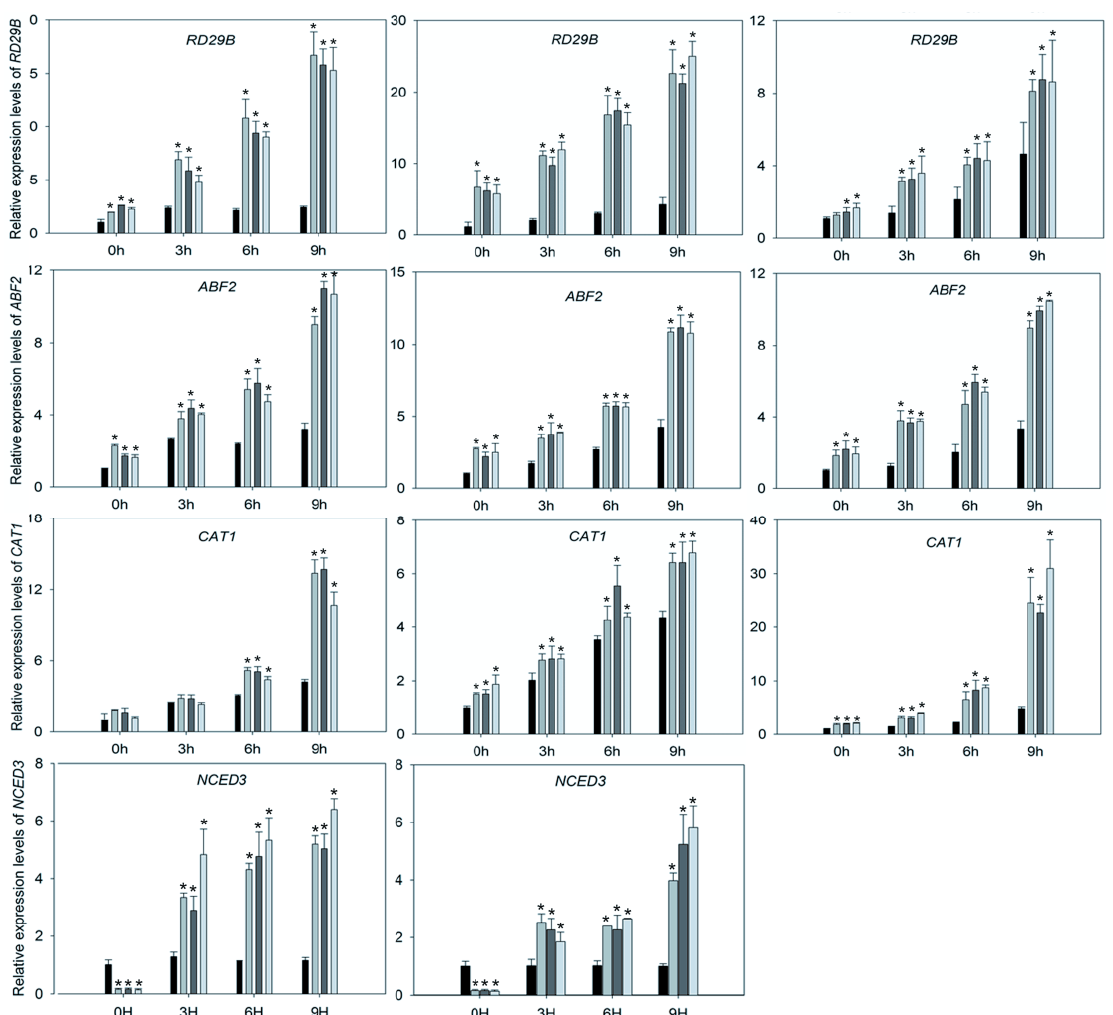
Figure 8. Results of qRT-PCR analysis on stress-related genes in response to ABA, mannitol and NaCl treatment. Expression profile in the first column are results of SpCIPK26 -OXP and WT irrigated with 0.2 μ M ABA, which in middle and right column are treated with 200 mM mannitol and 150 mM NaCl for 0, 3, 6 and 9 h, respectively. The SpCIPK26 -OXP and WT cultured on 1/2 MS for two weeks were subjected to stress treatments and values of each gene detected in wild type at 0 h was standardized to 1. Amplification of UBQ10 was used at internal control. Mean values and standard deviation (error bar) were calculated from three independent experiments and asterisk (*) above the bar stand for significant difference between wild type (Col) and transgenic lines (L2, L4 and L5) at p < 0.01.